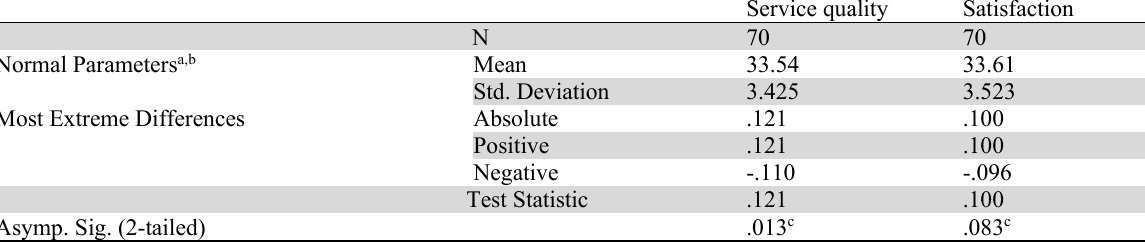
Service quality